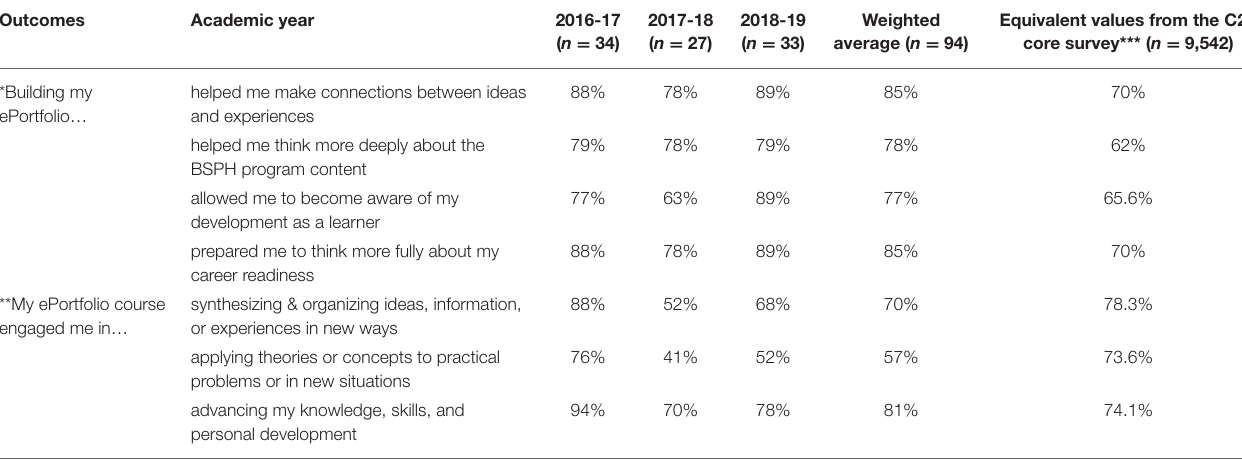
TABLE 2 | Student ratings of BSPH ePortfolio outcomes.